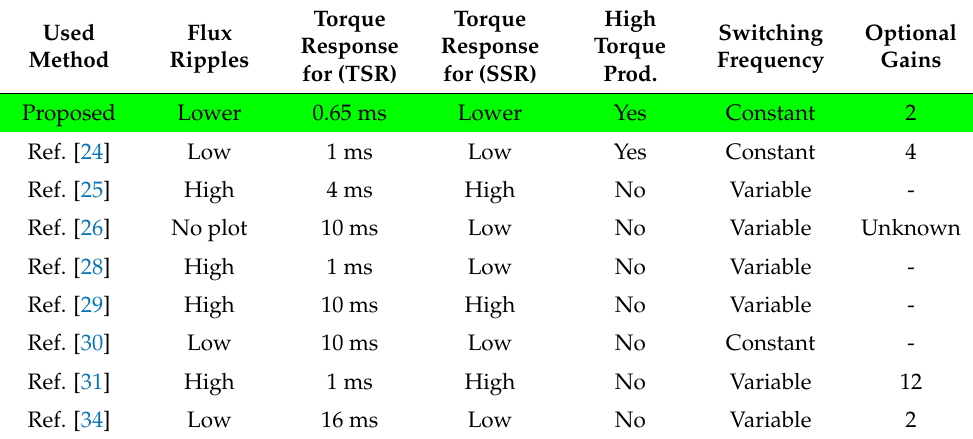
Table 3. Comparison between the proposed algorithm and previous and recent techniques.